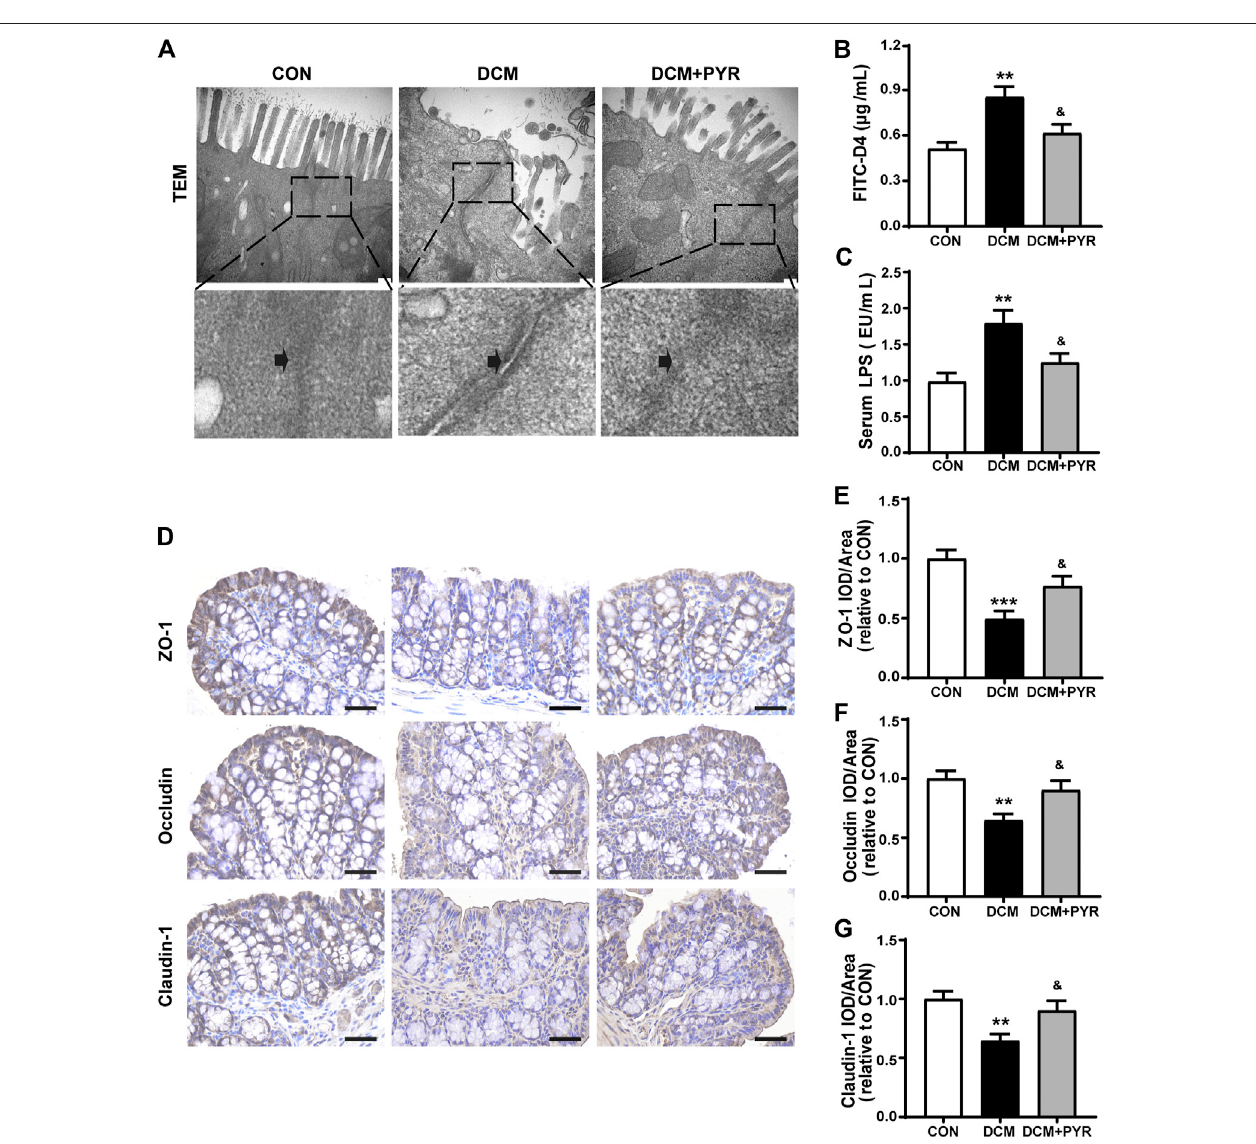
FIGURE 2 | The intestinal barrier was damaged in diabetic cardiomyopathy mice and attenuated by pyridostigmine. (A) TEM analysis of the TJs ultrastructure of intestinal tissue; scale bar (cid:1) 200 nm. (B) Serum FITC-D4 concentration. (C) Serum LPS concentration. (D – G) Immunohistochemical analysis of the expression of TJ proteins (ZO-1, occludin, and claudin-1) in intestinal tissue; scale bar (cid:1) 50 μ m. Data are expressed as the mean ± SEM. n (cid:1) 6 – 8. ** p < 0.01, *** p < 0.01, vs. CON; & p < 0.05, vs. DCM.